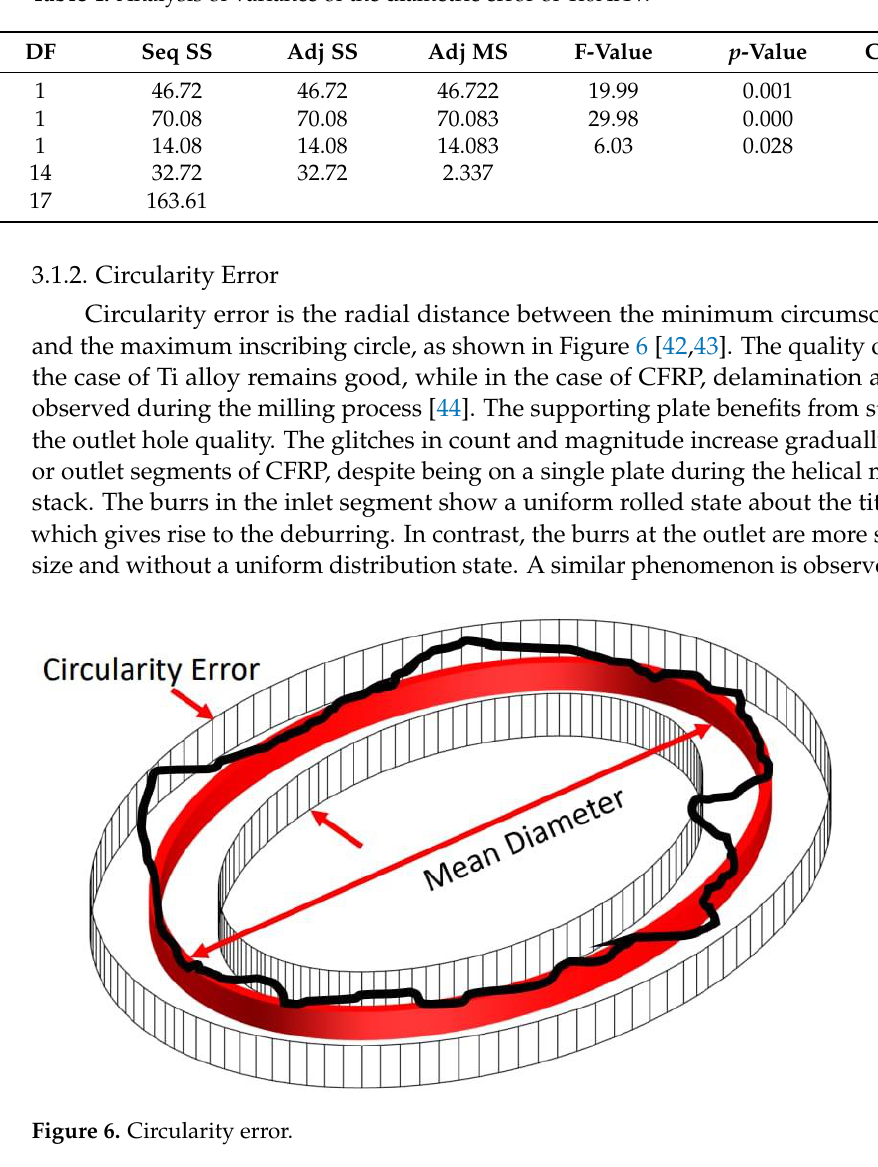
Table 5. Analysis of variance of the circularity error of the CFRP.